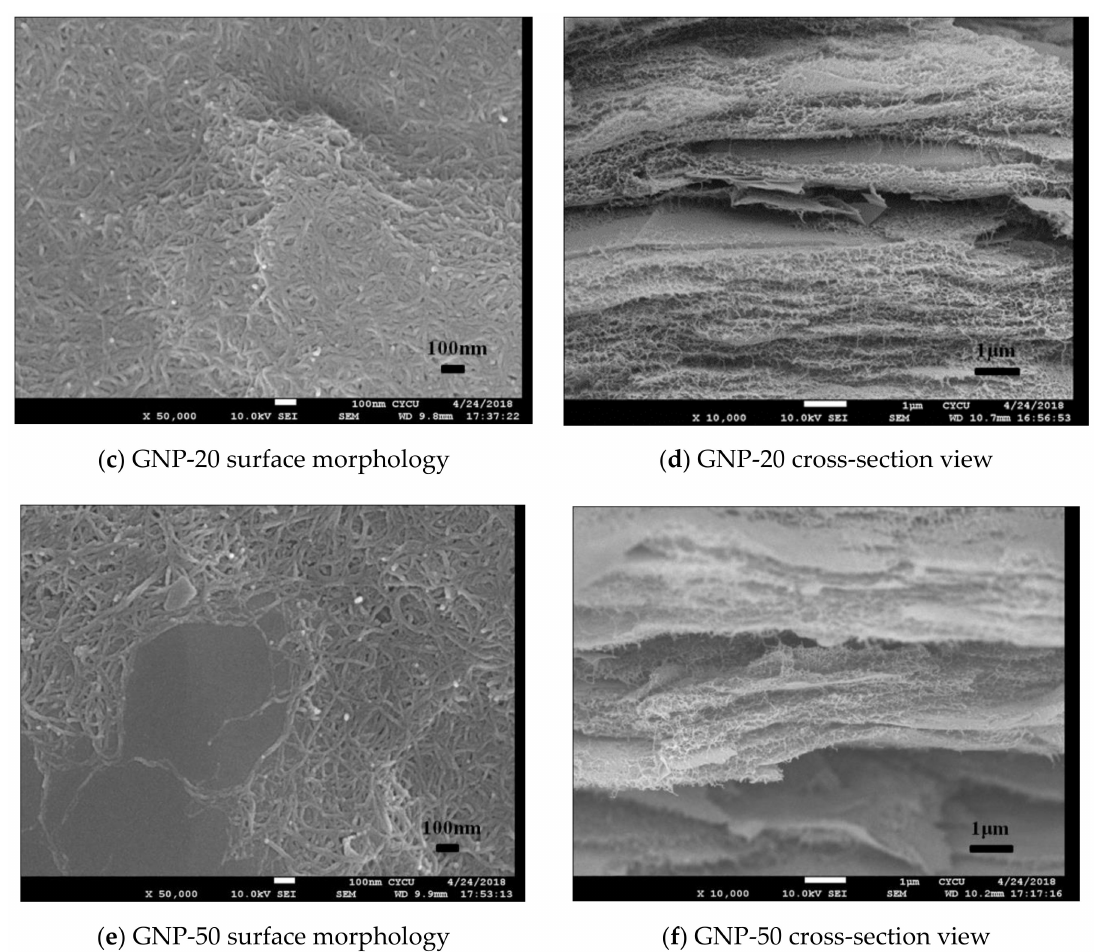
Figure 2. SEM images of hybrid films ( a ) surface morphology of GNP-0; ( b ) cross-section view of GNP-0; ( c ) surface morphology of GNP-20; ( d ) cross-section view of GNP-20; ( e ) surface morphology of GNP-50; ( f ) cross-section view of